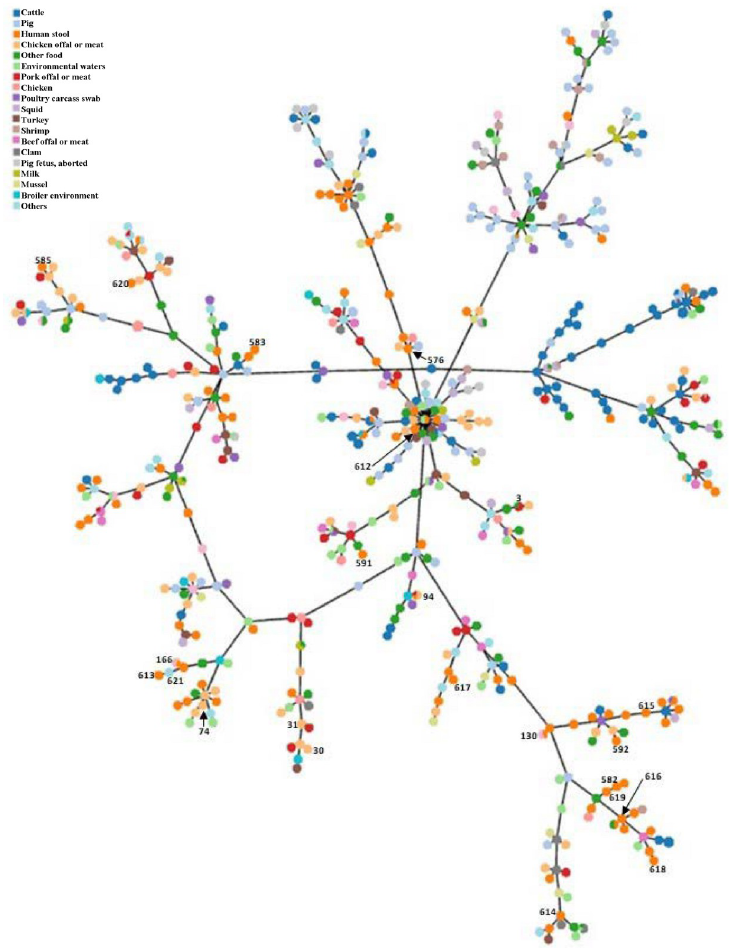
Fig 1. The Minimum Spanning Tree (MST) of all Arcobacter isolates in pubmlst database. This tree was constructed based on the concatenated sequences of seven housekeeping genes loci (3,341 bp) of 867 Arcobacter isolates obtained from the present study (n = 26) and the database (n = 841). The number beside the node indicates ST in the present